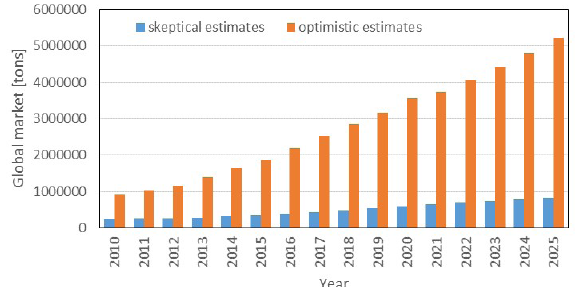
Figure 1: The global market for nanomaterials